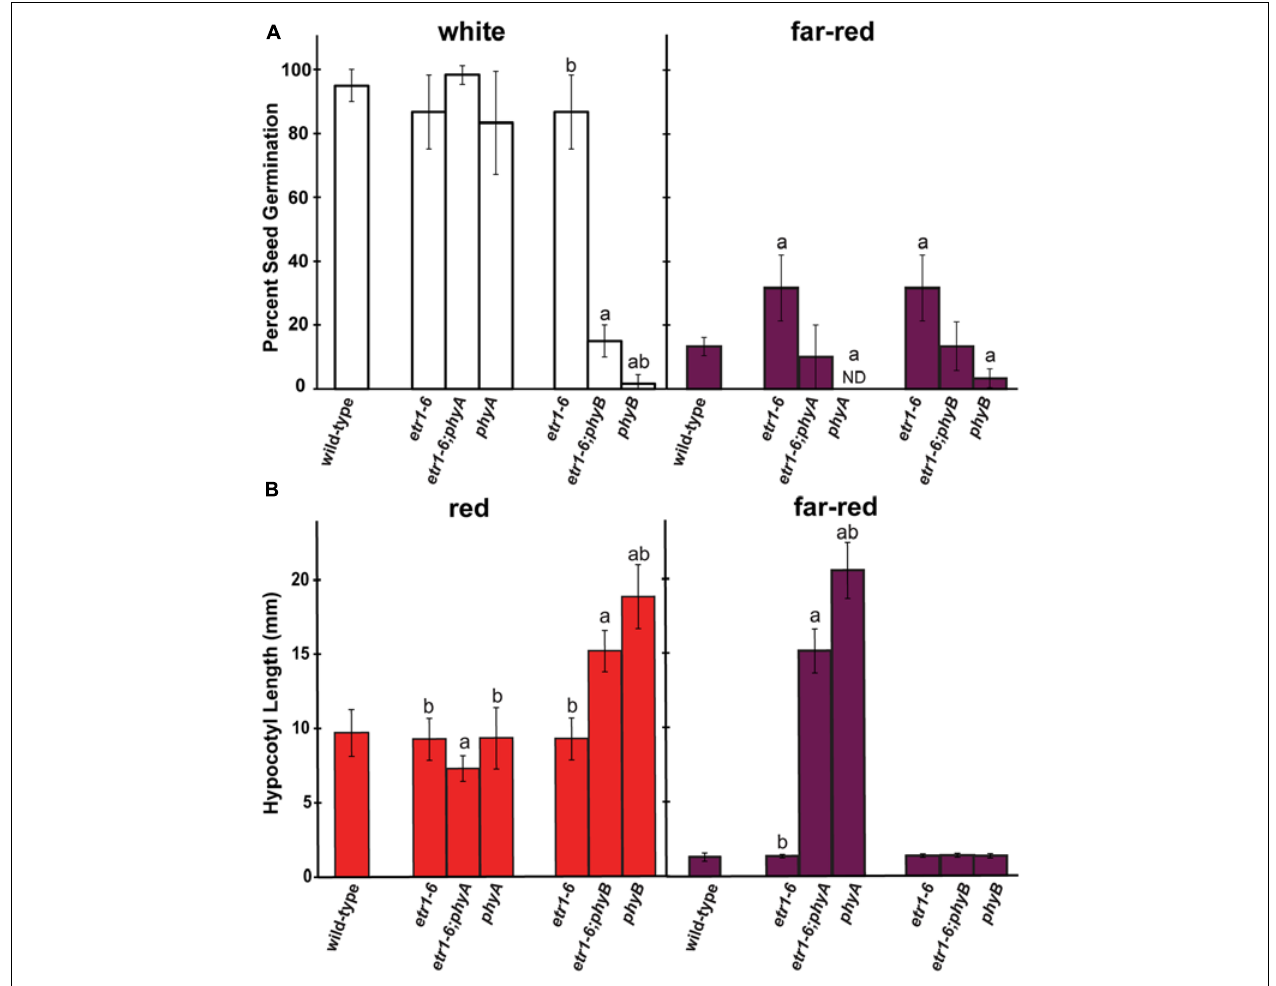
continuous illumination with red or far-red light for 6 days as shown.The lengths of the hypocotyls were then measured.The average ± SD is plotted. In both panels, the data were analyzed by t -tests and differences considered statistically significant with P < 0.05. a Statistical difference from wild-type in that light condition; b Significant difference of the single mutant from the